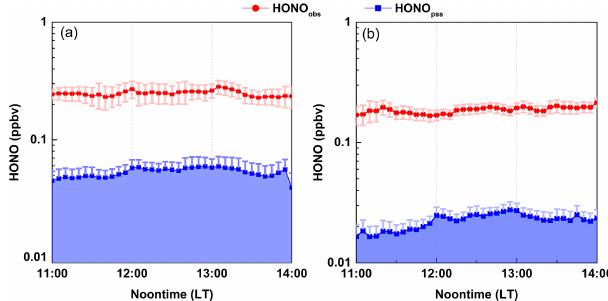
Figure 5. Average noontime [HONO] pss concentrations com- pared with the observed HONO concentrations in (a) winter and (b) spring. Shaded area indicates the level of [HONO] pss . Error bar indicates the standard error of